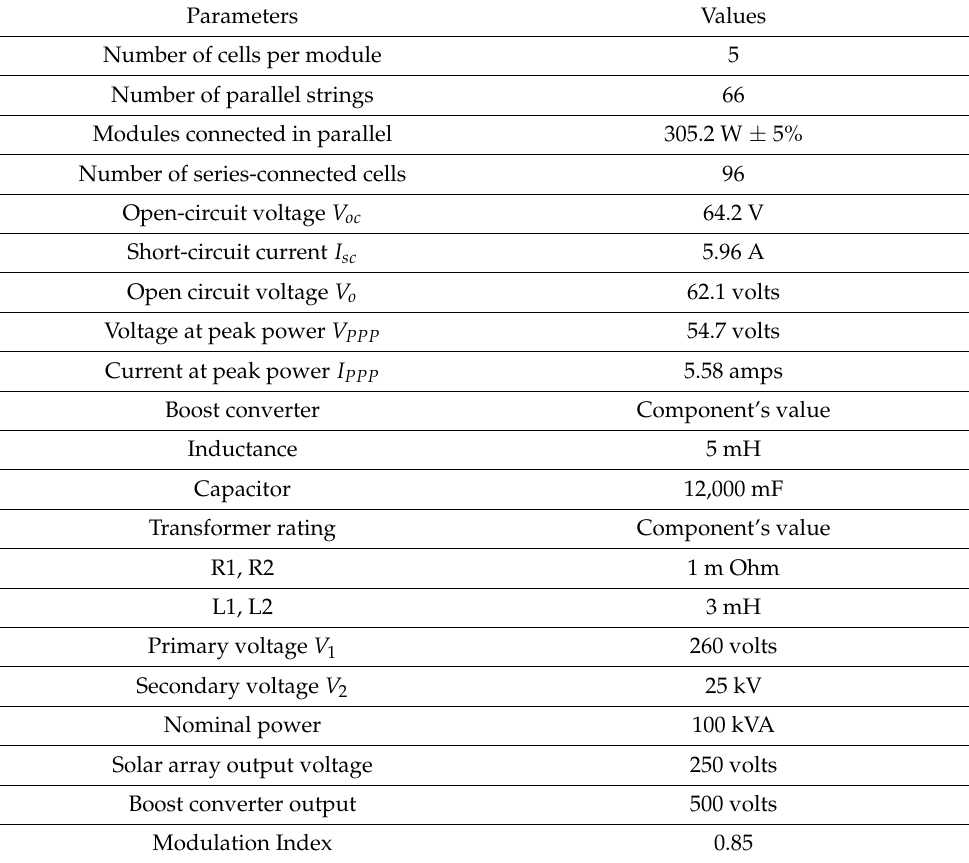
Table A1. Specifications used for the PV-module, Boost Converter and